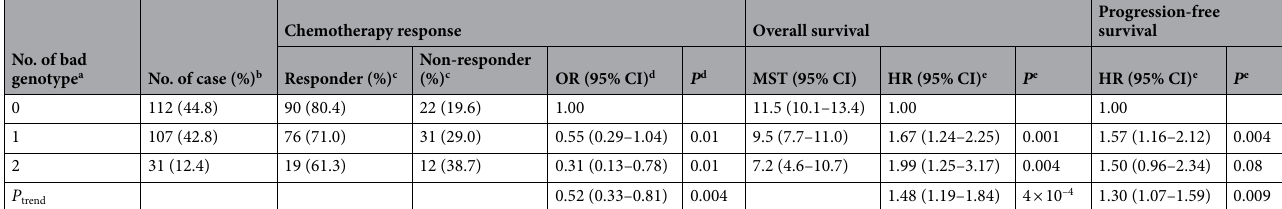
Table 3. Combined effects of rs1058402G > A and rs763361C > T genotypes on chemotherapy response and survival outcome. OR, odds ratio; CI, confidence interval; MST, median survival time (months); HR, hazard ratio. a Bad genotype; rs1058402GA/AA and rs763361CC. b Column percentage. c Row percentage. d OR, 95% CI, and their corresponding P -values were calculated by multivariate regression analysis, adjusted for age, gender, smoking status, stage, Eastern Cooperative Oncology Group performance status, weight loss, neuron specific enolase level, and first chemotherapy regimen. e HR, 95% CI and their corresponding P -values were calculated using multivariate Cox proportional hazard models, adjusted for age, gender, smoking status, stage, Eastern Cooperative Oncology Group performance status, weight loss, neuron specific enolase level, first chemotherapy regimen, second line chemotherapy, and radiation to primary tumor.